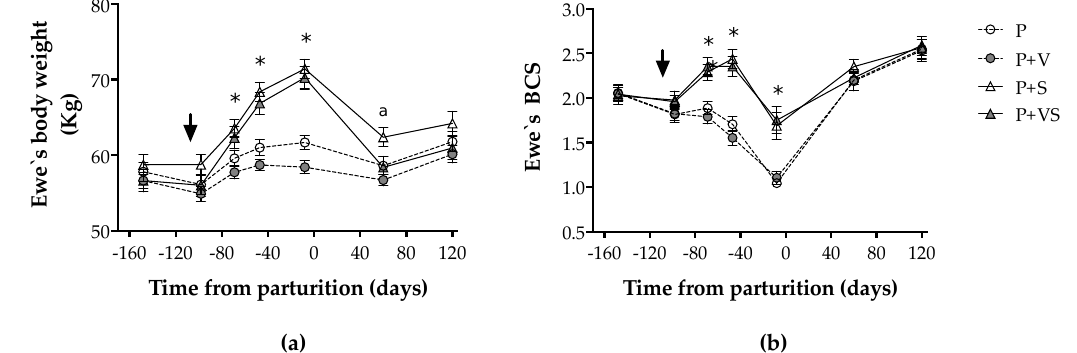
Figure 1. Mean ( ± SEM) body weight ( a ) and body condition score (BCS); ( b ) during pregnancy and subsequent lactation in twin-bearing ewes, maintained under extensive Magellan conditions and consuming only natural pasture (group P), natural pasture plus vitamin supplementation (group P + V), natural pasture plus concentrate supplementation (group P + S), and natural pasture plus vitamin and concentrate supplementation (group P + VS). The arrow shows the time when vitamins and / or nutritional supplementation begun. Asterisks indicate significant di ff erences between sheep supplemented and non-supplemented with concentrate at the same sampling point, while symbol alpha indicates significant di ff erence between P + S and P + V ( p < 0.05).